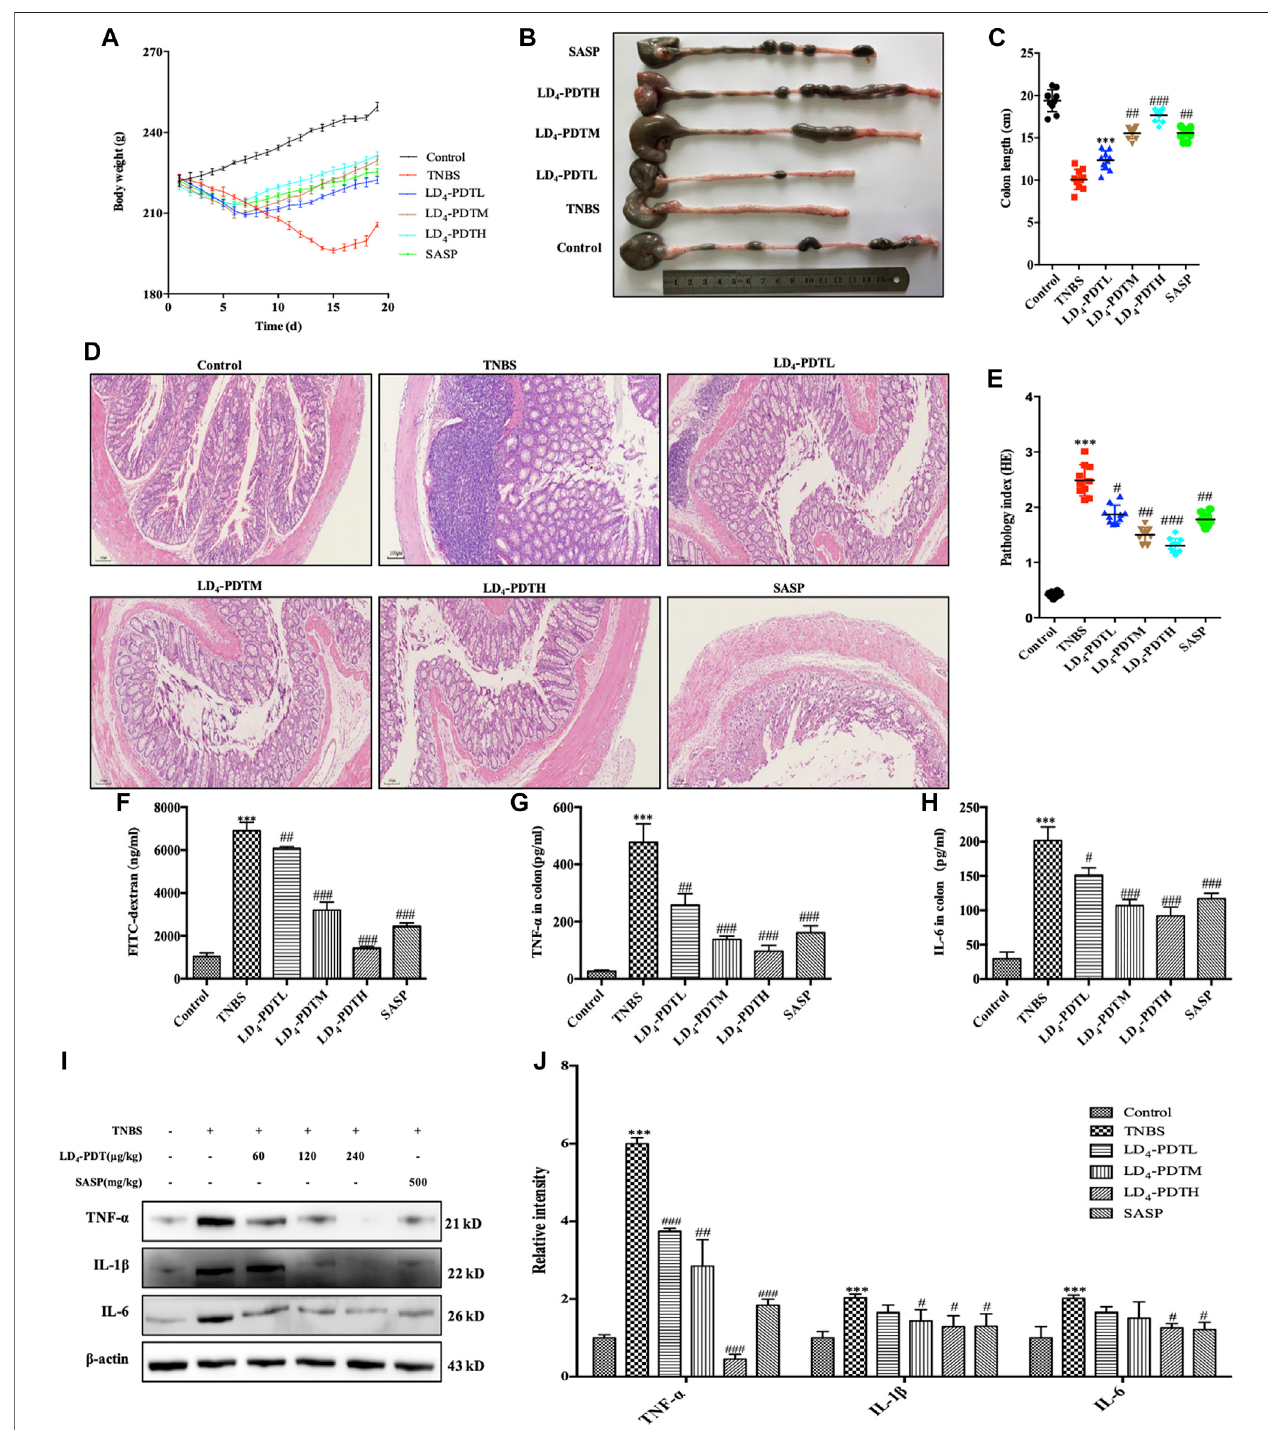
FIGURE 2 | LD 4 -PDT alleviated TNBS-induced UC in model rats. (A) Body weight of UC model rats changed with time. (B,C) Length of colon. (D,E) Hematoxylin andeosinstainingofcolontissueandin fl ammationscore. (F) Serum fl uorescentintensityofFITC-dextran. (G,H) TNF- α and IL-6 levelsdeterminedbyELISA. (I,J) Protein expression of TNF- α , IL-6 and IL-1 were determined by western blot analysis. Each column represents the mean ± SD of 10 rats per group. ** p < 0.01 , *** p < 0.001 vs control group; # p < 0.05 , ## p < 0.01 , ### p < 0.001 vs TNBS-treated group.